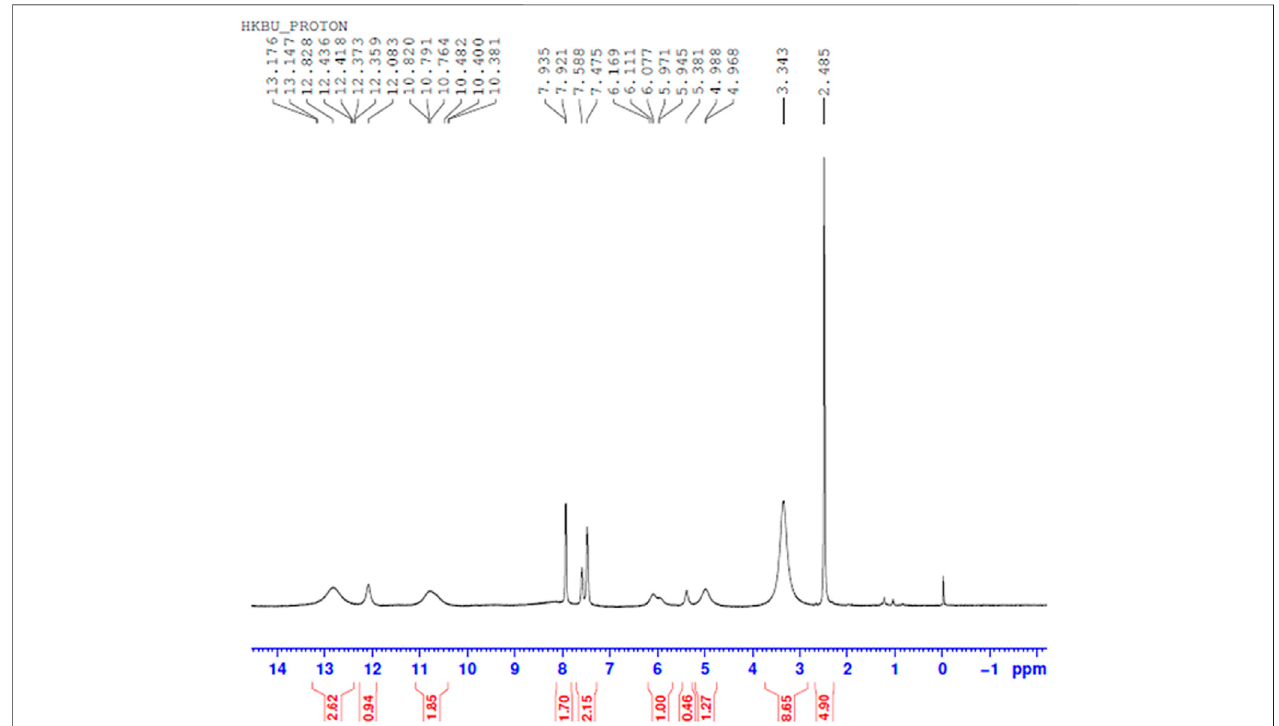
FIGURE 10 | 1 H NMR spectrum resulting from the addition of benzoic acid to ferric sulfate solution at 30 ° C to obtain precipitated product.